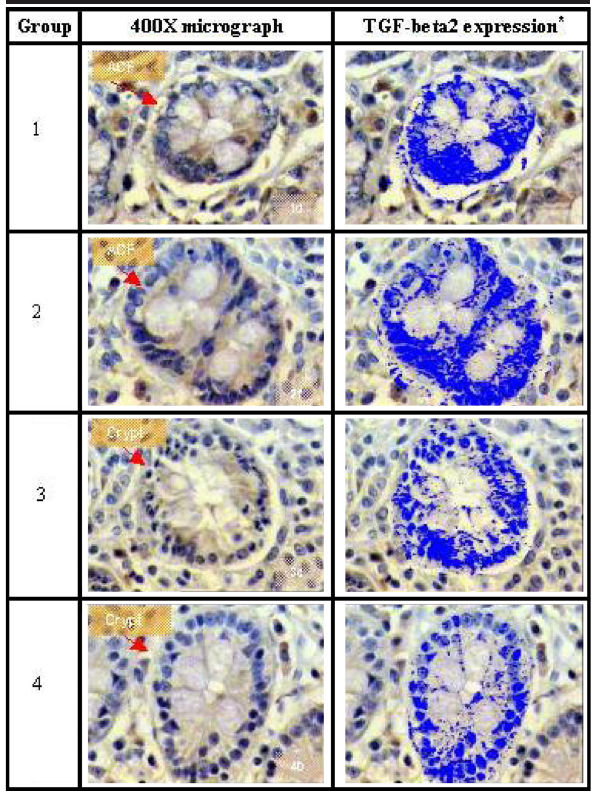
FIGURE 3 - Computer-assisted image processing. TGF-beta2 was quantified by computer-assisted image processing with ImageLab software. One single image from each sample was captured, which was centered either on the crypt or the ACF. The quantified brown coloration density corresponds to TGF-beta2 expression in area percentage (using a RGB filter, blue background, 0- to-147 color interval) in the selected crypt or